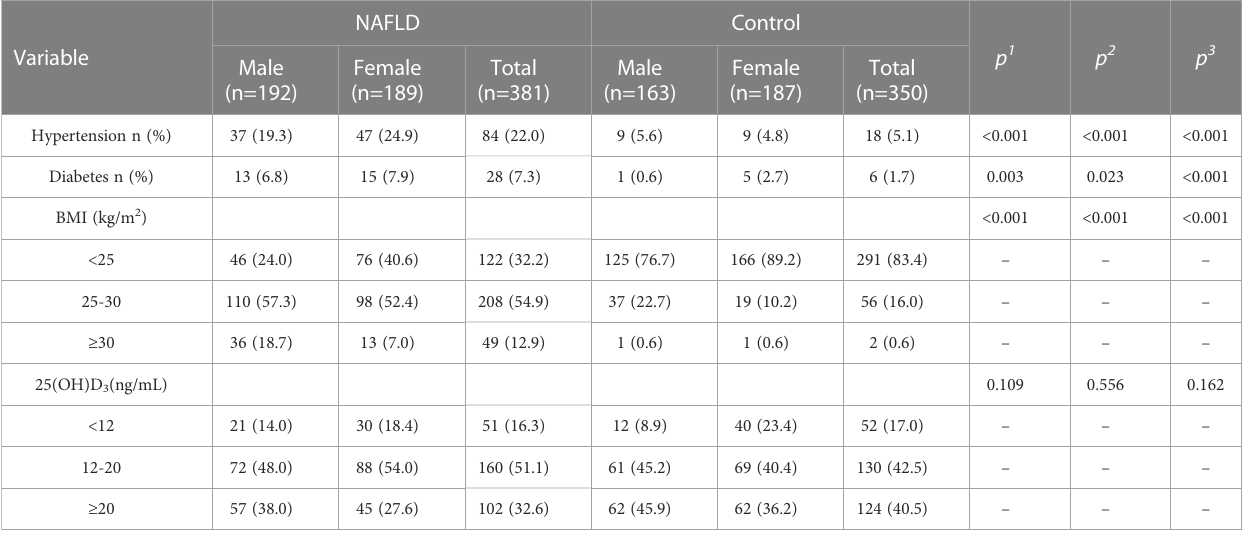
TABLE 2 Description of counting data in NAFLD and controls.